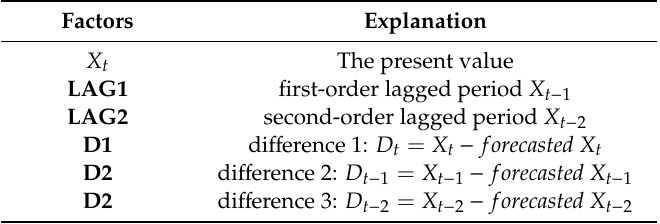
Figure 1. Explicit processes of data input and complementary ensemble empirical mode decomposition (CEEMD) parts of the CEEMD-fuzzy time series (FTS) multi-objective grey wolf optimizer (MOGWO)-LSTM (CFML) model. Table 1. The selected input variables for long short-term memory